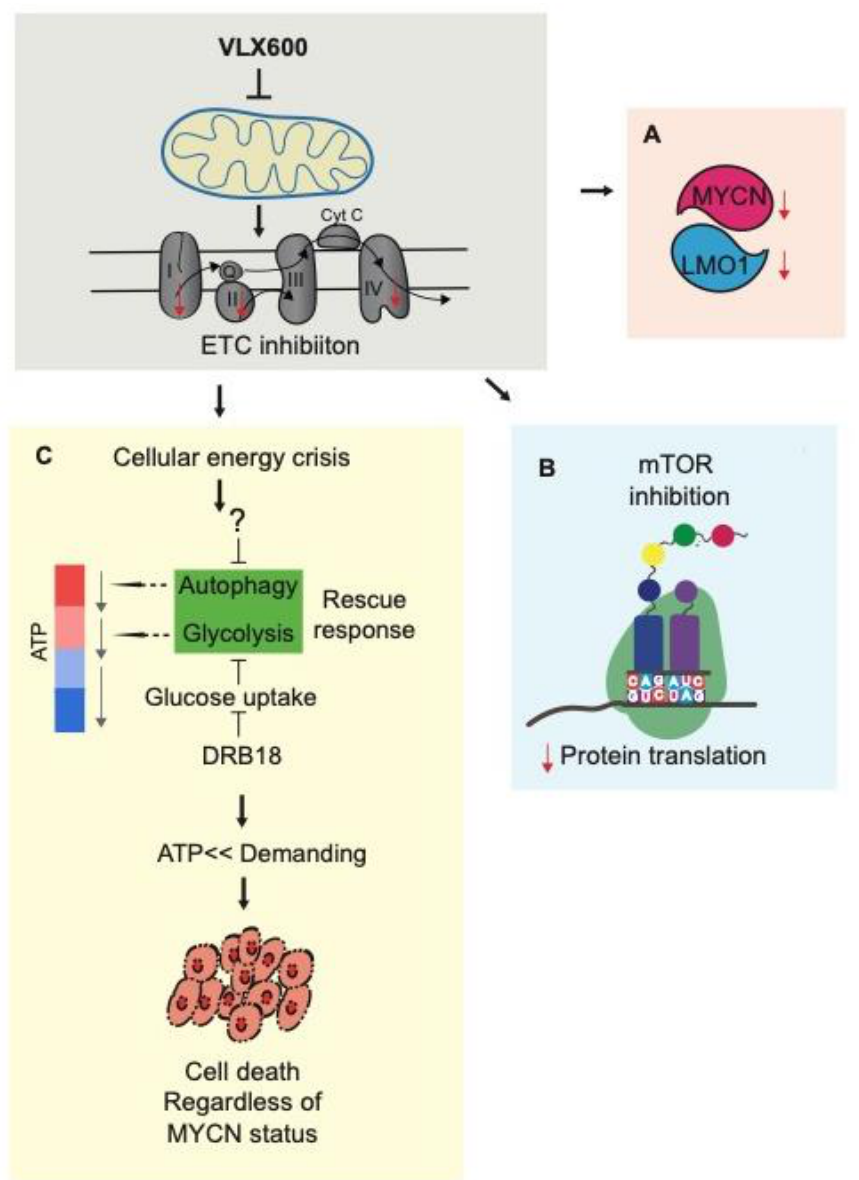
Figure 8. Illustration of the effect of VLX600 in neuroblastoma cells. VLX600 inhibits